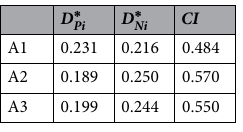
Table 10. The relative variables and CI s.